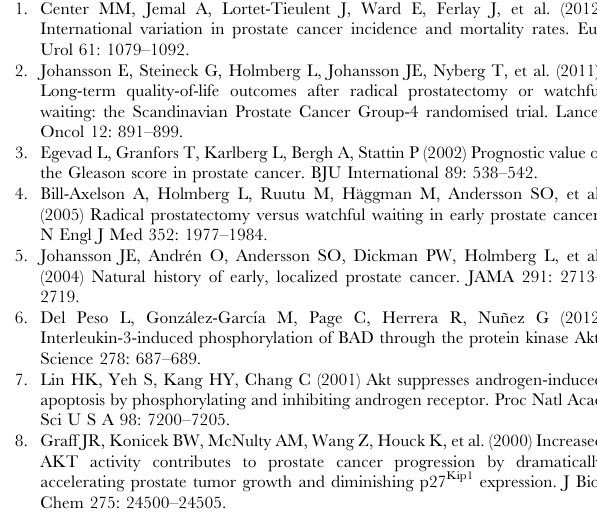
and B) and Ki67-IR (Panels C and D) for patients followed by expectancy; influence of Gleason score.